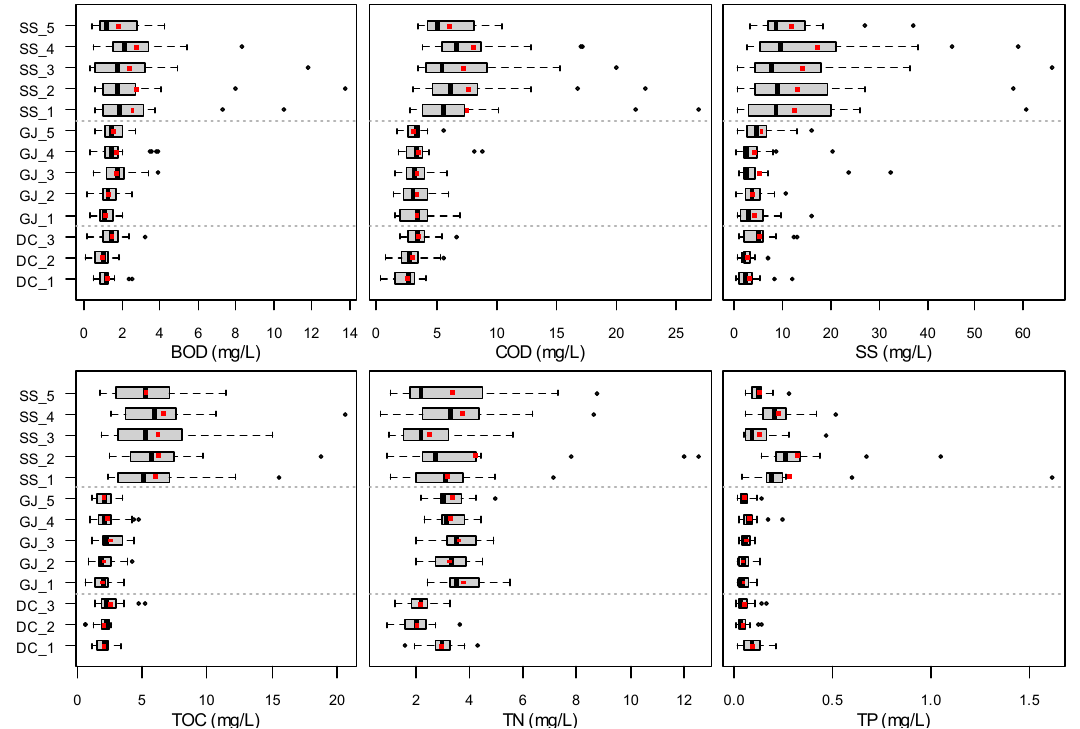
Figure 4. Boxplot of water quality concentration at each monitoring site during dry days over the monitoring period (red dot: average).